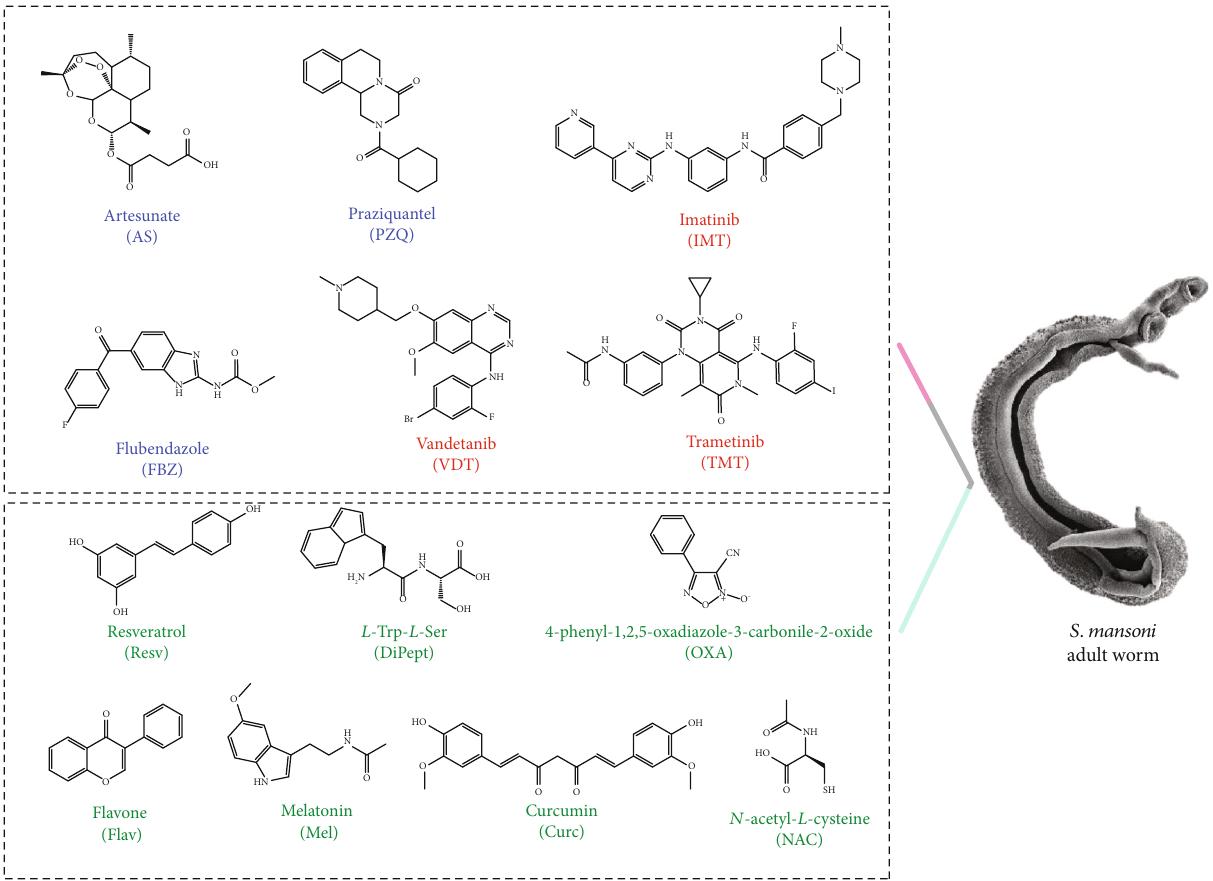
Figure 1: Structures of anthelminthic drugs, anticancer drugs, and antioxidant biomolecules evaluated either alone or combined against S. mansoni adult worms. The anthelmintic drugs are depicted in blue, anticancer drugs in red, and antioxidant biomolecules in green. PZQ: praziquantel; FBZ: fl ubendazole; AS: artesunate; DiPept: L -Tyr- L -Ser; Resv: resveratrol; Mel: melatonin; Flav: fl avone; NAC: N -acetyl- L - cysteine; Curc: curcumin; OXA: